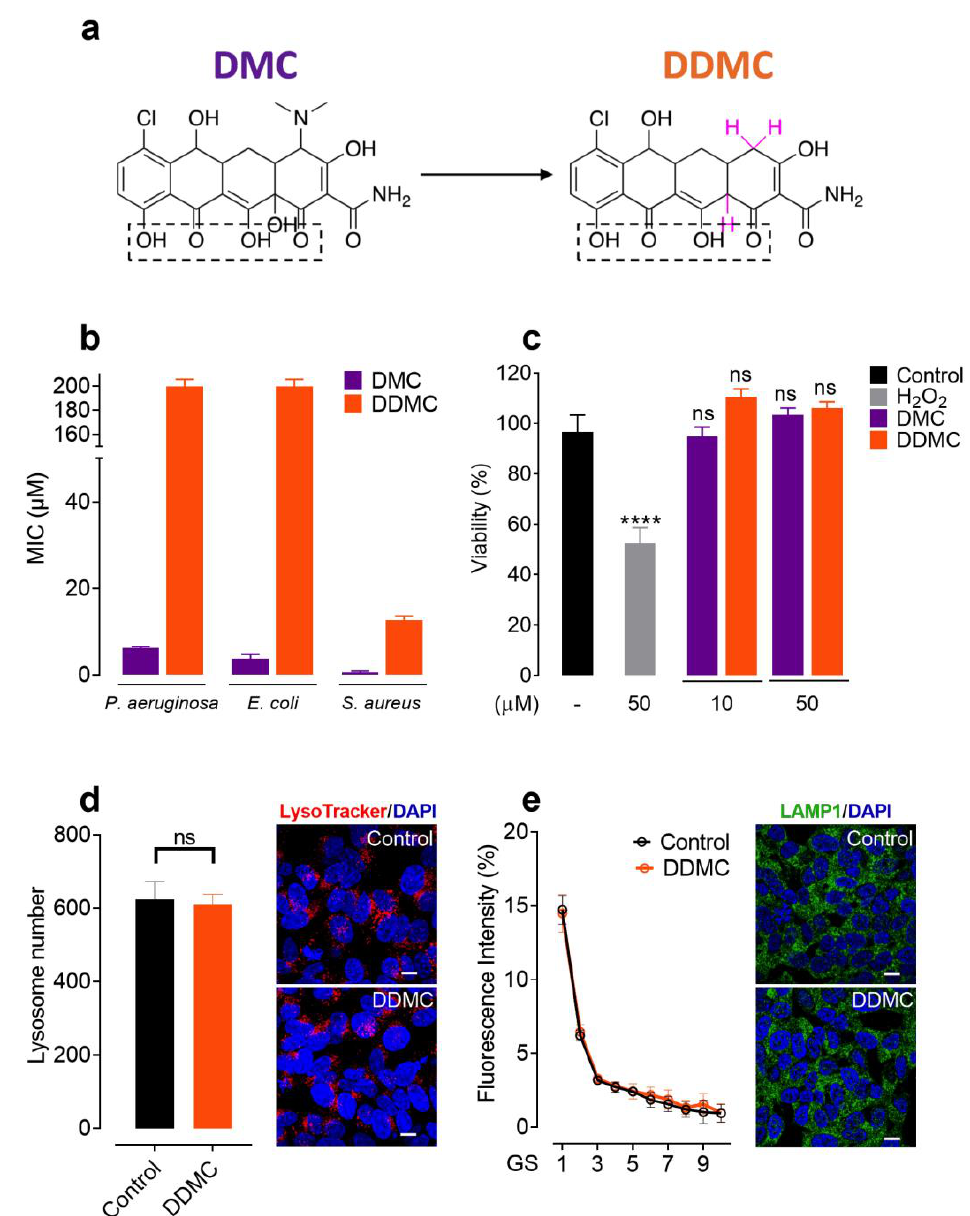
Figure 1. The novel TC DDMC is innocuous in bacteria and human cells. ( a ) Synthesis of DDMC via the treatment of DMC with zinc in acetic acid and water for 2 h at room temperature. The hydrogen atoms incorporated due to the reduction step are shown in pink. The dashed-line box points to the structural signature related to binding with amyloid-like aggregates. ( b ) Antibiotic activities of DMC and DDMC against P. aeruginosa (PAO1), E. coli (ATCC 25922), and S. aureus (ATCC 25923). MICs are shown in µ M. ( c ) MTT cell viability assay in SH-SY5Y cells after 24 h treatment with DMC or DDMC (10 or 50 µ M final concentrations) and hydrogen peroxide (H 2 O 2 ) as a positive control (50 µ M). All experiments were performed in sextuplicate, and relative cell viability was expressed as a percentage relative to the untreated control cells. Statistical analysis was performed as described in Materials and Methods, and significant differences are indicated in the figures as follows: **** p < 0.001 vs. control; ns (not significant)— p > 0.05 vs. control. ( d ) The effect of 10 µ M DDMC on lysosome numbers was assessed using LysoTracker TM Deep Red staining in SH-SY5Y cells and confocal microscopy. ( e ) The number of LAMP1-positive vesicles was estimated using immunostaining and captured with a confocal microscope. Lysosome quantification for ( c ) and ( d ) was performed with the granularity module in CellProfiler 4.2.1